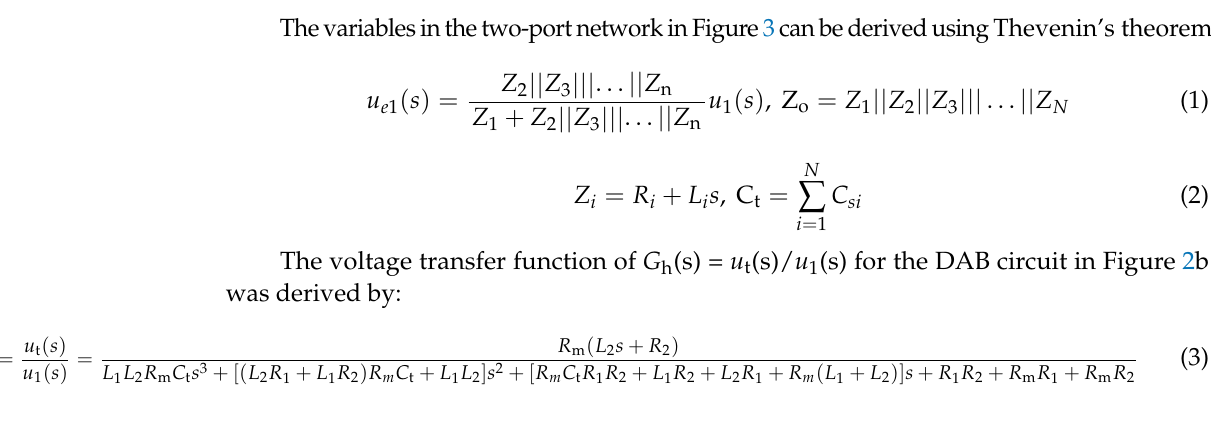
Figure 3. Thevenin equivalent circuit.